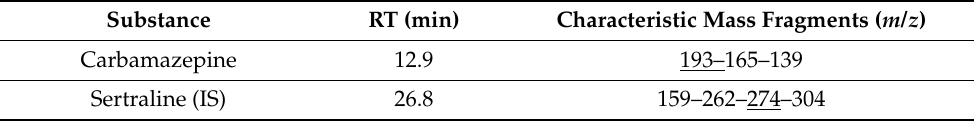
Table 2. Retention times and characteristic ions of analyzed substances by